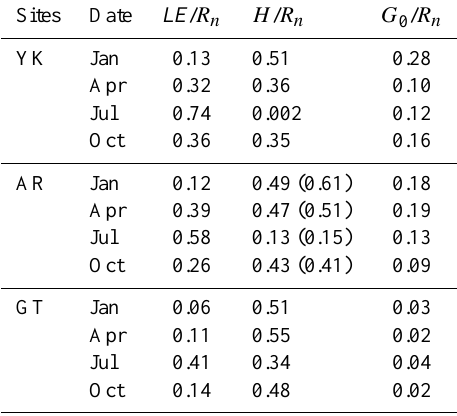
Table 3. Ratios of the monthly LE , H , G 0 to R n during different seasons at the three sites in 2008 (08:00–19:00BST; January and April 2009 at AR; values in the bracket are H LAS /R n ).